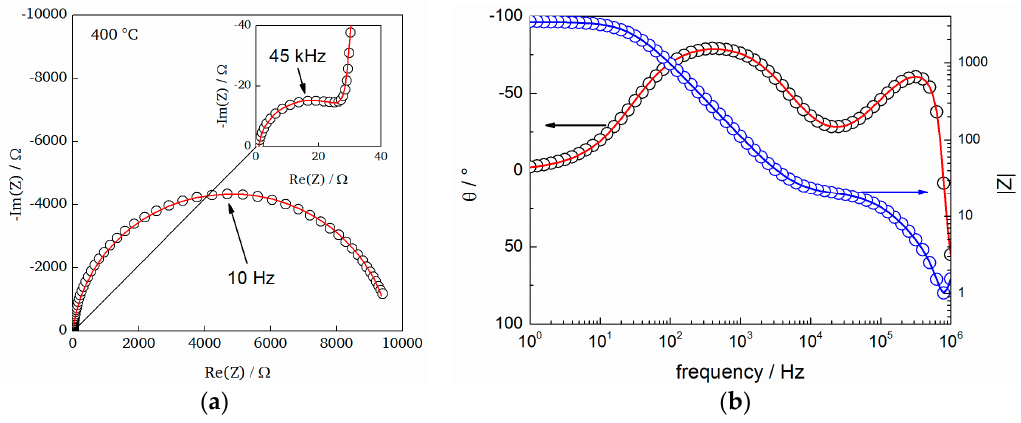
Figure 9. ( a ) Characteristic Nyquist plot, including Zview fits (using the model in Figure 1b) with the corresponding ( b ) bode plot for a measurement at 400 °C (Ar atmosphere).